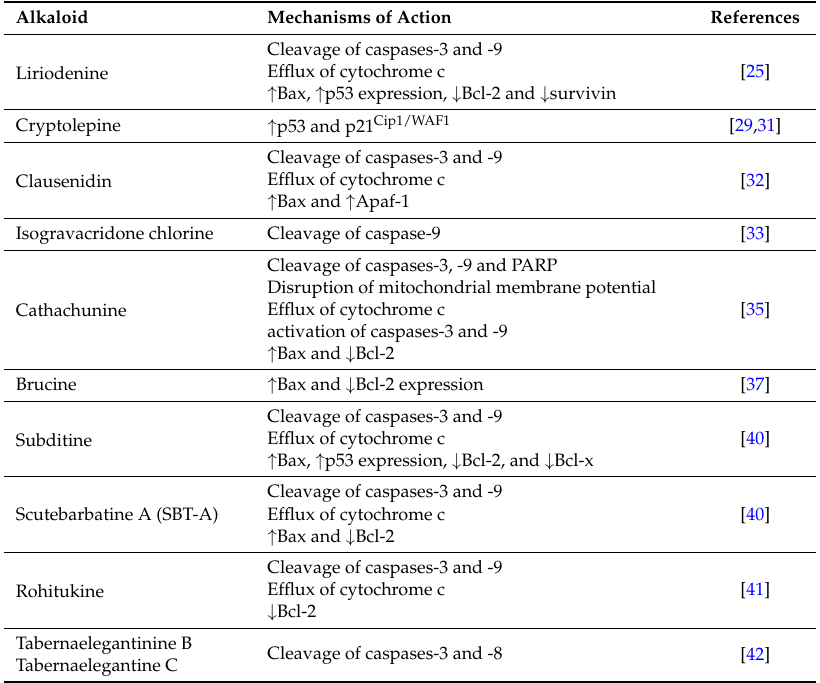
Table 3. Apoptotic mechanisms of emerging plant-derived